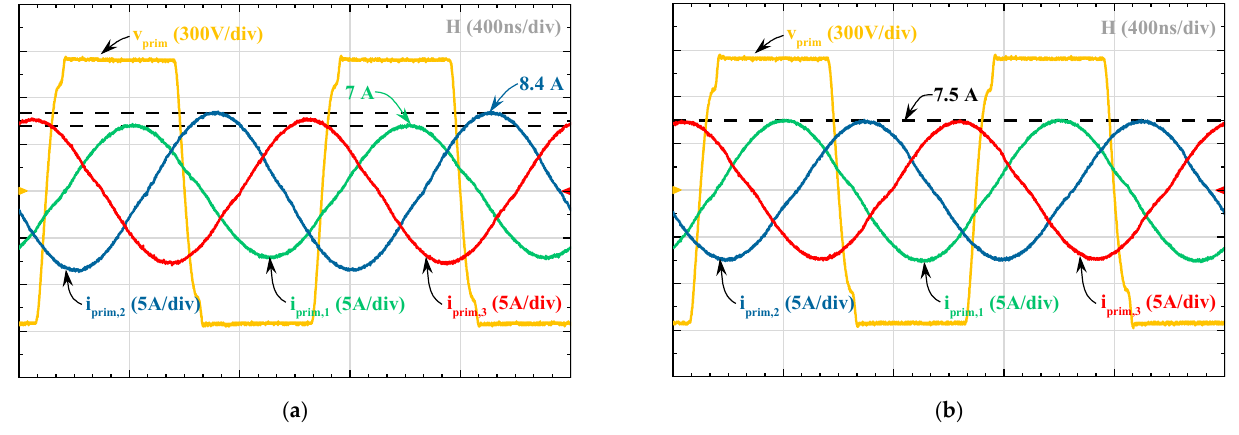
Figure 27. Experimental waveforms of three-phase operation of the dc/dc stage with 800 V battery voltage and full load ( P ac = 11 kW) with ( a ) symmetry control inactive and ( b ) symmetry control active. The measured efficiency of the portable off-board charger is shown in Figure 28.